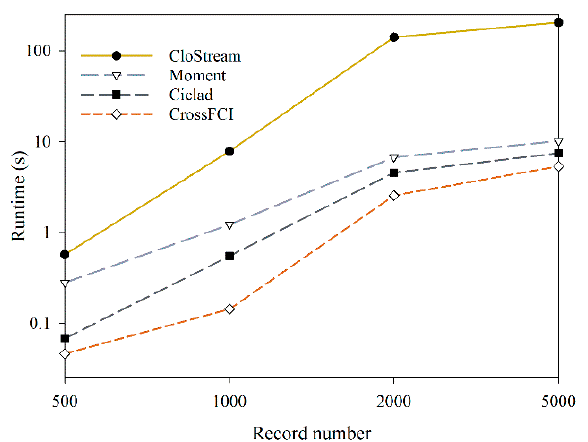
Figure 12. Performance comparison results of different FCIM algorithms on the MPAMS datasets with different sizes.